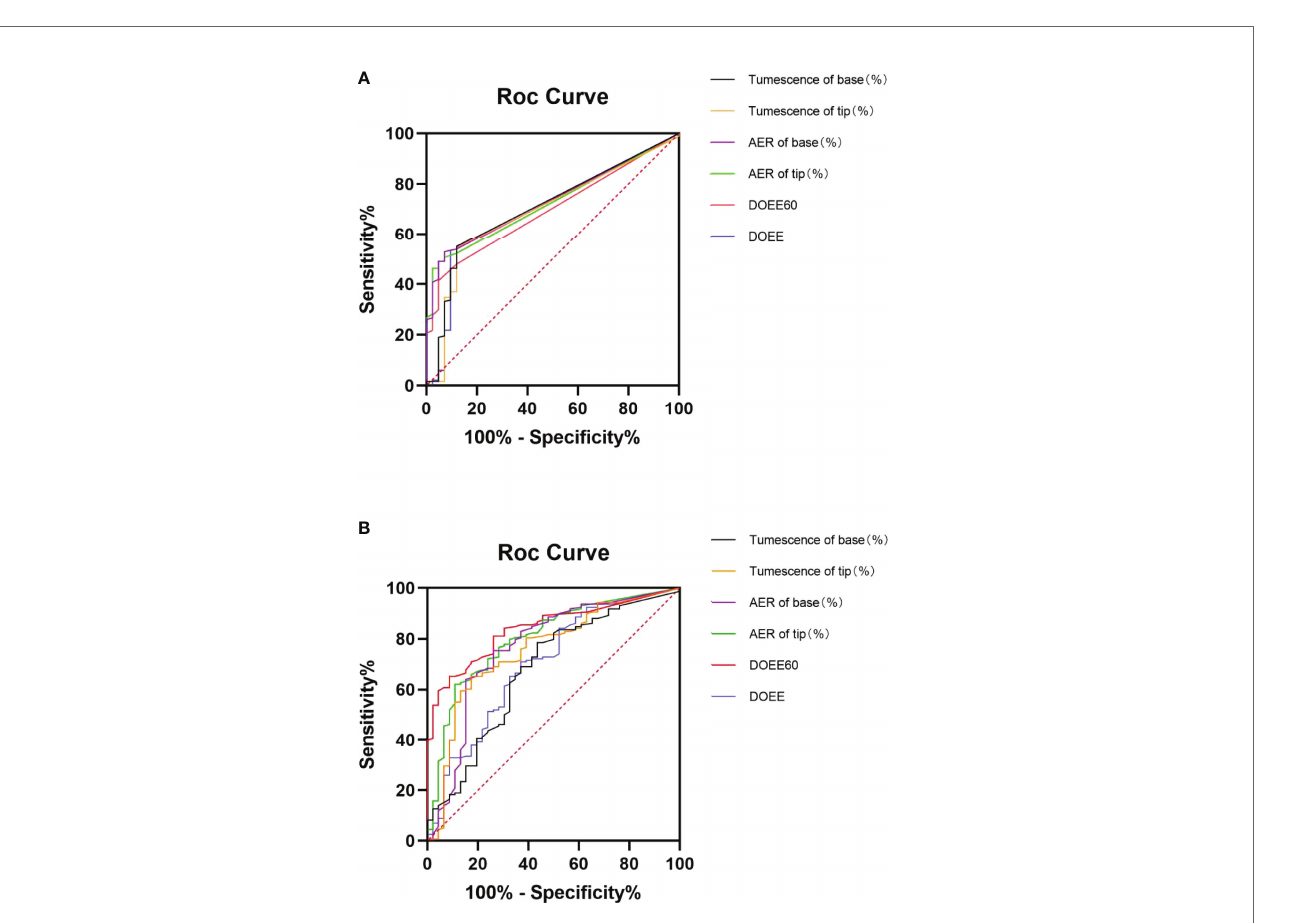
FIGURE 1 | ROC curve of AVSS (A) and NPTR (B) parameters for predicting tadala fi l responders. Six NPTR parameters, compared to AVSS parameters, may reliably identify tadala fi l responders following 4-week 5 mg daily dosing, with signi fi cantly greater accuracy in DOEE60 in NPTR than other parameters. AER is for average event rigidity; DOEE stands for a duration of erectile episodes; ROC stands for receiver operator characteristic; AVSS stands for audiovisual sexual stimulation, and NPTR stands for nocturnal penile tumescence and